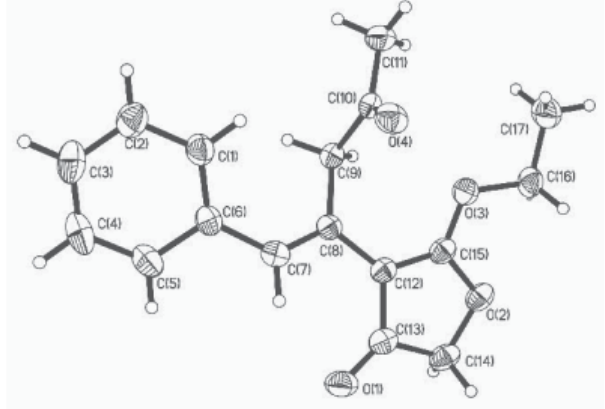
U iso (H) = 1.5 U eq (methyl).